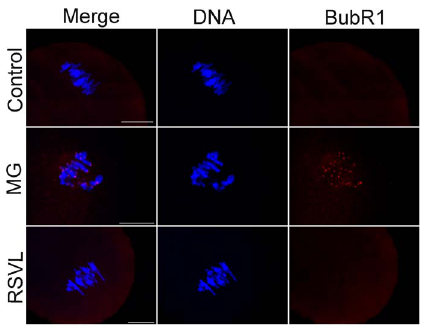
Figure 7. Effect of MG and resveratrol treatment on the activity of SAC protein BubR1. Detection of BubR1 in oocytes in control group, MG-treated group and RSVL-MG-treated group. Red, BubR1; blue, DNA. Scale bar =20 m m.